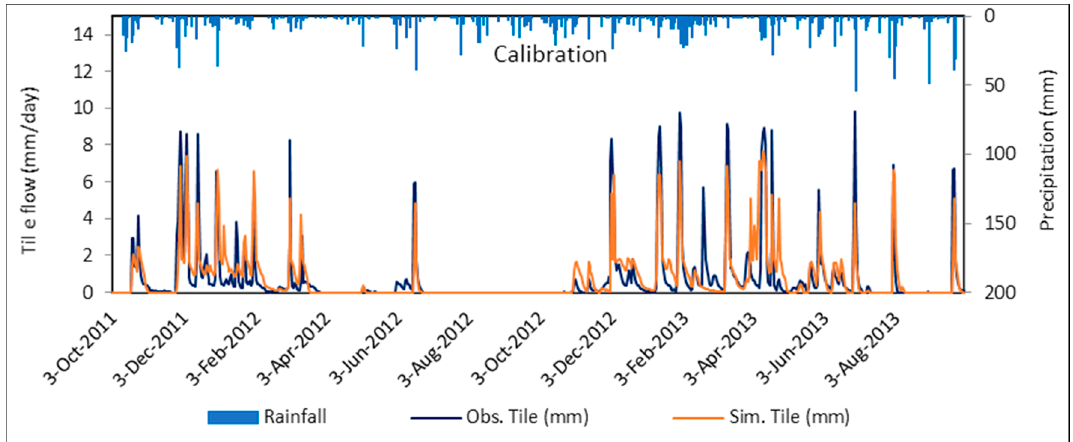
Figure 1. Measured tile discharge (blue line) and precipitation (blue bars) and simulated tile discharge (orange lines) during the model calibration.